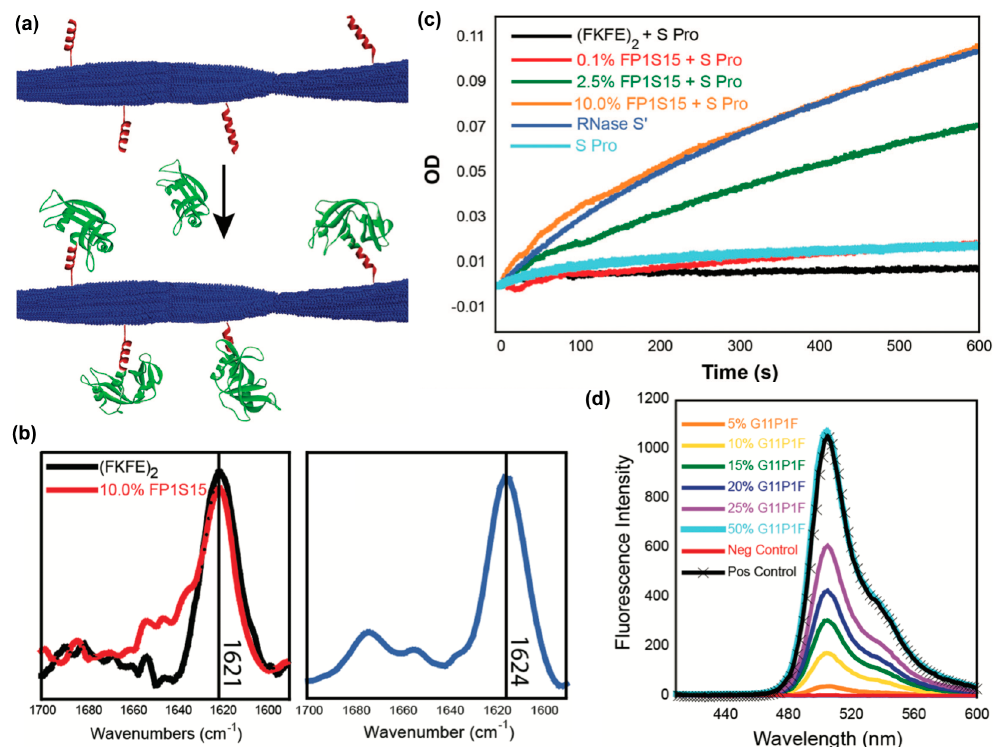
Figure 10. Immobilizing proteins onto peptide nanofibrils via split tag. ( a ) Graphical representation of non-covalent protein conjugation onto self-assembled peptide nanofibrils using a split protein strategy. Blue: a self-assembling peptide (Ac-(FKFE) 2 -NH 2 ); red: peptide tag; green: split protein fragments. ( b ) Fourier-transform infrared (FT-IR) spectra indicating that 10% co-assembled FP1S15/Ac-(FKFE) 2 -NH 2 fibrils and 20% G11P1F/Ac-(FKFE) 2 -NH 2 fibrils (20% G11P1F) adopt a β -sheet secondary structure. ( c ) Optical density curves of cytidine 2 ′ ,3 ′ -cyclic monophosphate hydrolysis catalyzed by self-assembled nanofibrils with different amounts of ribonuclease S tag in the presence of ribonuclease S’. ( d ) Spectra of green fluorescence produced by self-assembled nanofibrils with different amounts of GFP 11 tag in the presence of GFP 1-10. Control spectra are GFP 1–10 alone (red) and GFP 1–10 + GFP 11 (black). Reproduced from reference [113] with permission from The Royal Society of Chemistry.